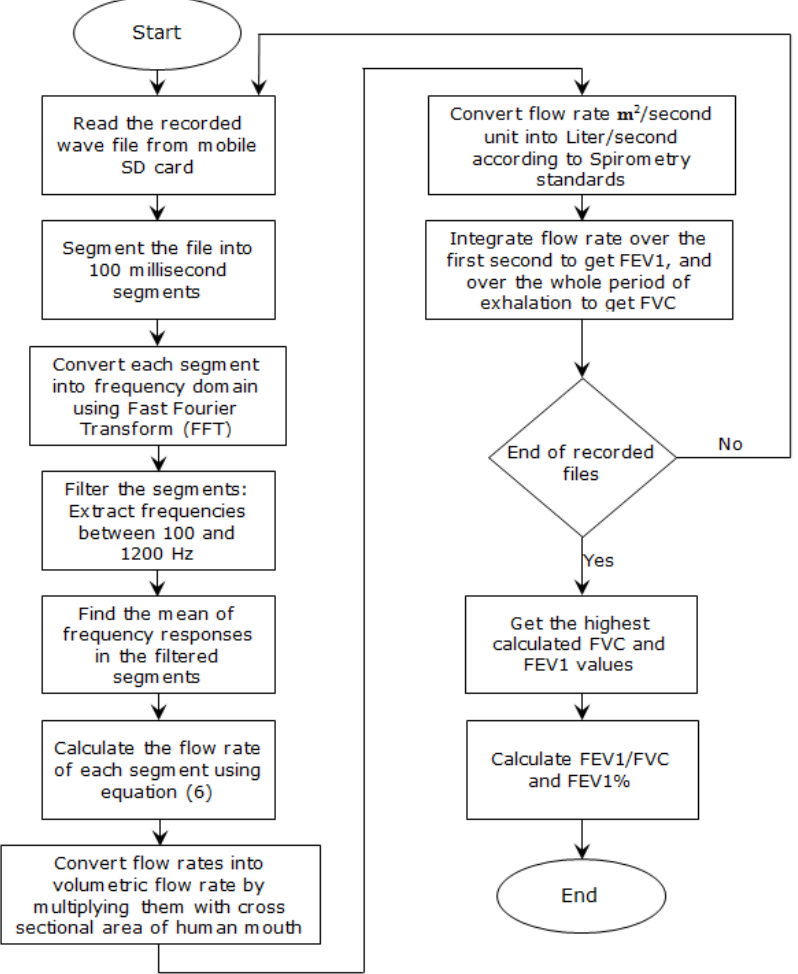
Figure 1. Flow chart explaining how to calculate the parameters forced vital capacity (FVC) and forced expiratory volume in one second (FEV1).